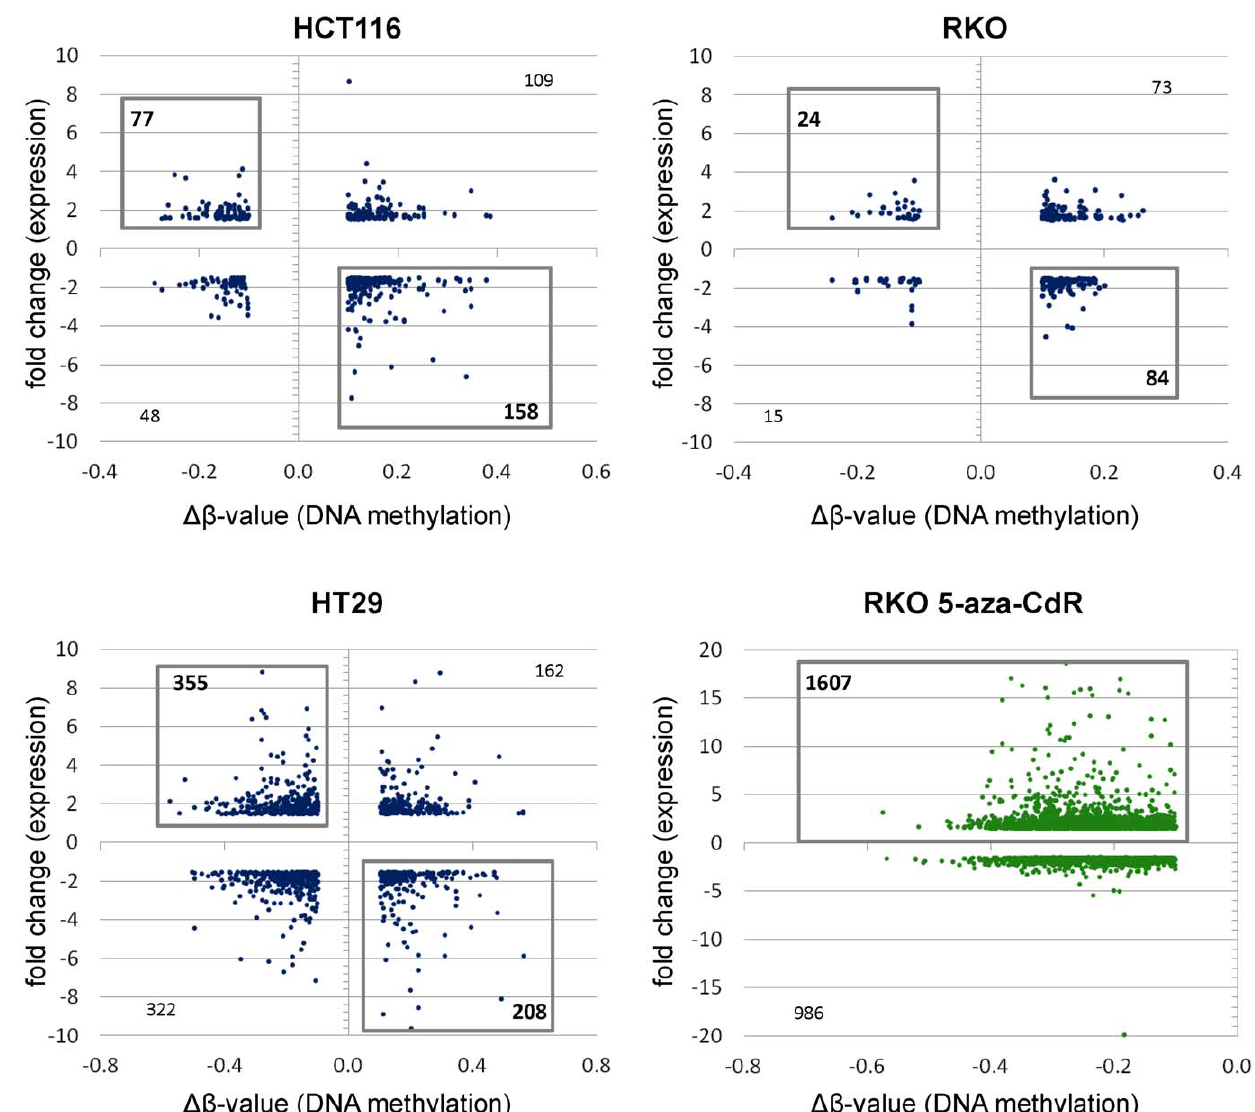
Figure 6. Changes in curcumin-mediated modification of DNA methylation correlate with changes in gene expression. To evaluate if curcumin-mediated changes in DNA methylation correlated with gene expression variation, we performed genome-wide gene expression analyses. Genes that showed reproducible DNA methylation changes after curcumin treatment ( Db . 0.1) were matched with genes that showed $ 1.5-fold differences in gene expression. The black boxes include those genes that showed an inverse correlation between methylation and gene expression changes.